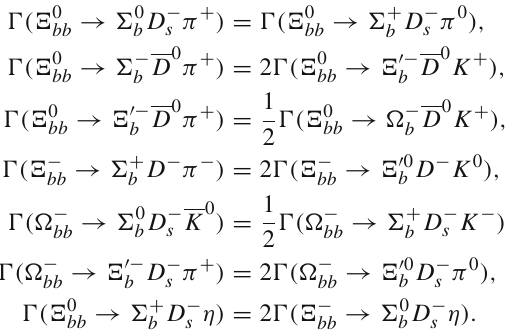
→ (cid:2) (cid:4)− π + ) = 2 (cid:15)((cid:5) − (cid:15)((cid:5) − D − s bb b → (cid:6) + η) = 2 (cid:15)((cid:2) − (cid:15)((cid:2) 0 D − s bb b A.8: (cid:2) bb and (cid:5) bb decays into a bottom baryon and two light mesons For the anti-triplet baryon, we have → (cid:2) 0 π 0 K 0 ) = 3 (cid:15)((cid:2) 0 (cid:15)((cid:2) 0 bb b